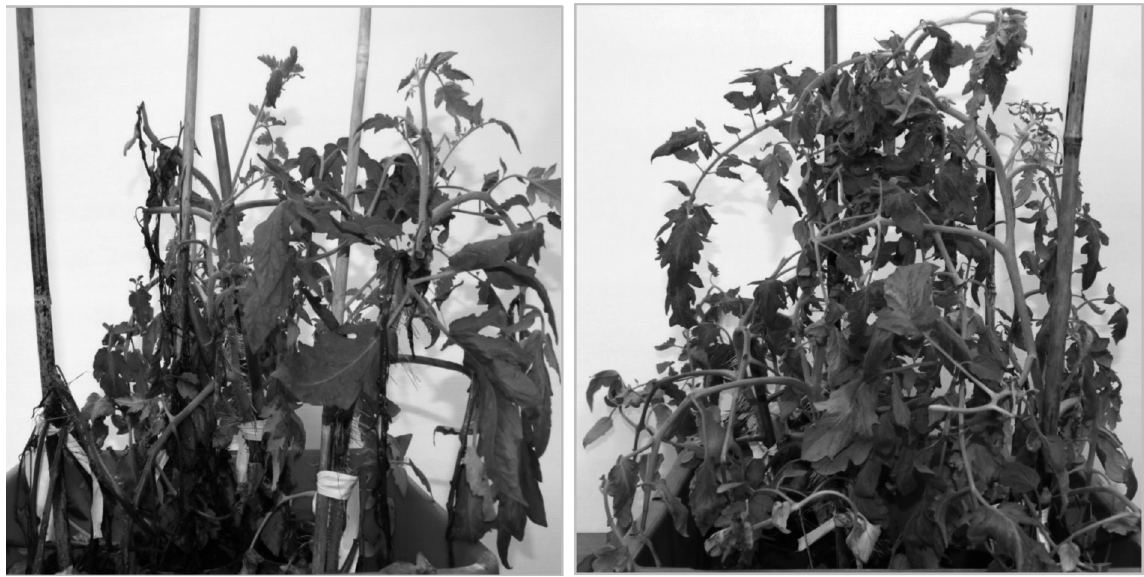
Figure 1. Tomato plants infected by Botrytis cinerea conidia spray at ten days following infection. Plants were grown in a coconut fiber:tuff potting mixture without biochar (left) or amended with 1% (w:w) greenhouse waste biochar (GHW-350) produced at an HTT of 350°C (right). B. cinerea infection was made after three week-growth of the plants in a 23–27°C growth chamber with no